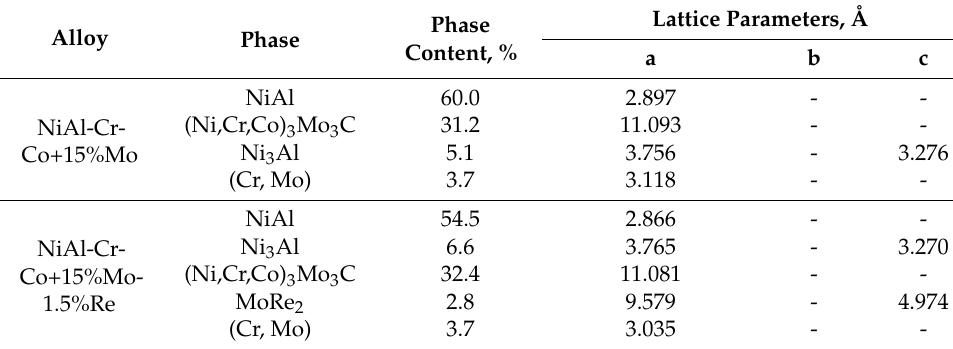
Table 8. The phase composition of the NiAl–Cr–Co–( X ) alloys.